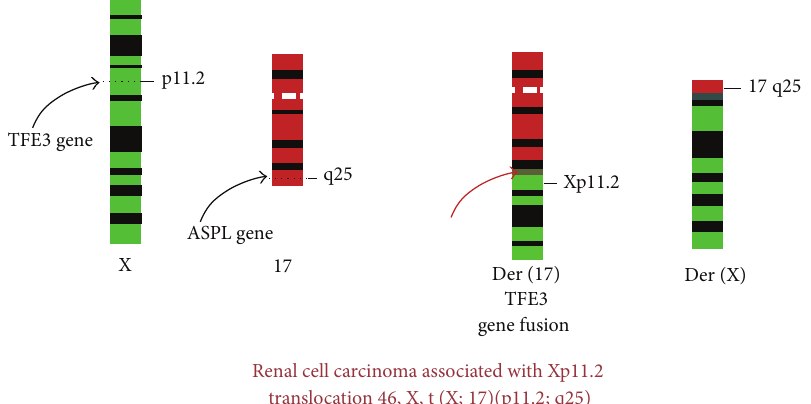
Figure 1: Renal cell carcinoma associated with Xp11.2 translocation 46, X, t(X; 17)(p11.2; q25).